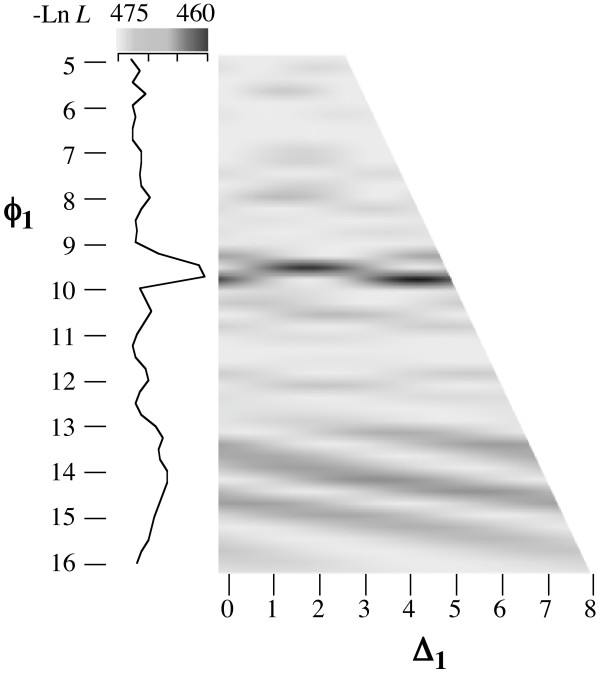
Map of-Ln Likelihood with varying φ1 and Δ1 parameters for 2002 nesting season.